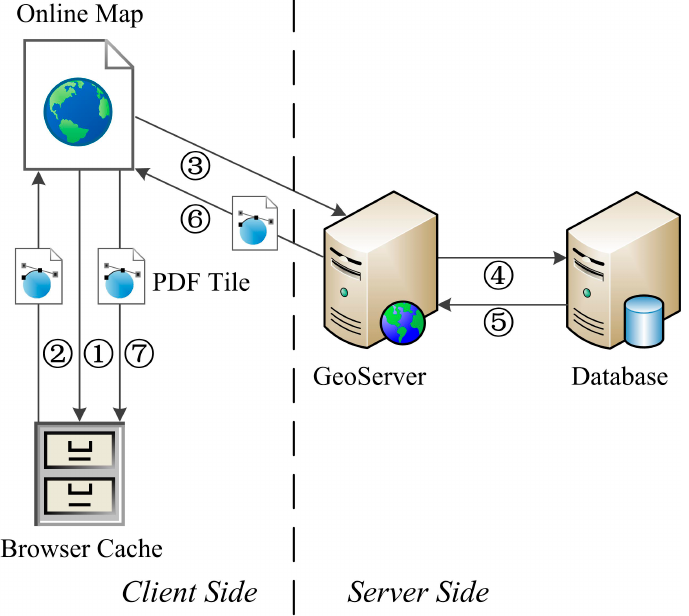
Figure 17. Online map system architecture based on a vector tile service. Numbers 1, 3 and 4 denote